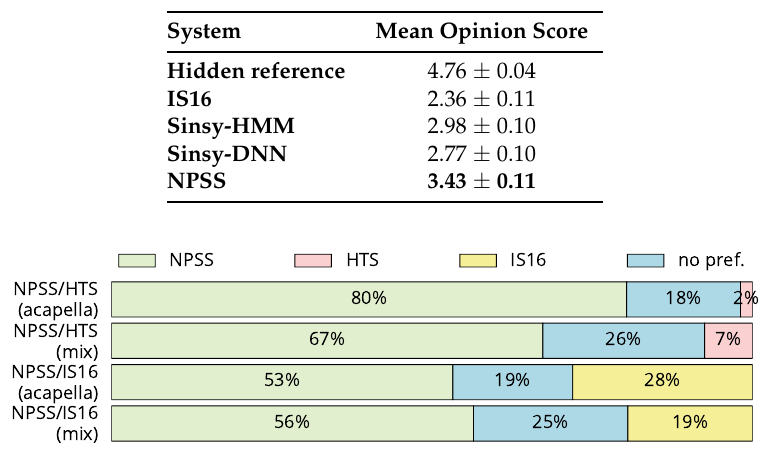
Table 5. Mean opinion scores for systems trained on natural singing, displayed on a 1–5 scale with their respective 95% confidence intervals. The HTS system is only considered when comparing systems trained on pseudo singing, but should be roughly equivalent to Sinsy-HMM.